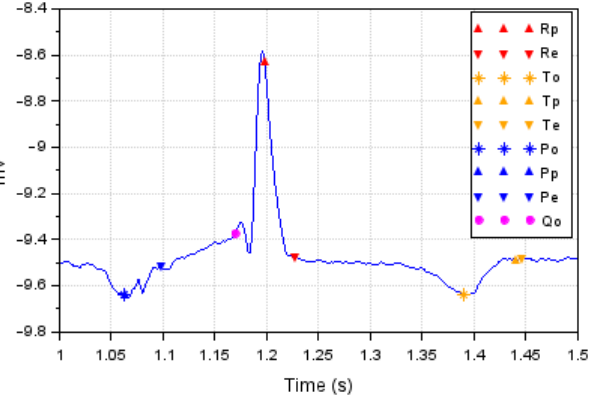
Figure 1. A normal ECG waveform for one cardiac cycle representing positive and negative deflection from baseline.